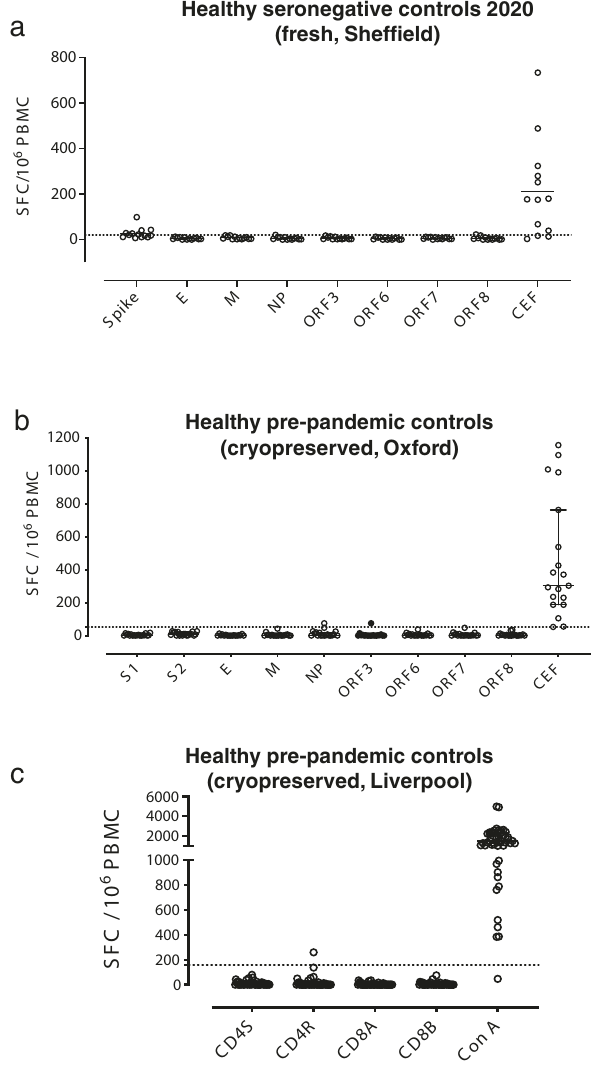
(Supplementary Fig. 5d, P = 0.066 by Wilcoxon ’ s two-tailed test). We again examined cytokine expression in these patients. The low level of responses, as these individuals were not screened using ELISpot, prevented us from effectively examining CD8 + T cell cytokine expression. However, there were suf fi cient indivi- duals with enough responding cells to examine CD4 + T cytokine expression for M ( n = 10), NP ( n = 4), S1 ( n = 6) and S2 ( n = 3). The vast majority of cells expressed 1 – 2 functional markers (with similar patterns), with small populations of cells expressing 3 or 4 (Supplementary Fig. 5). These results were similar to the ELISpot positive individuals mentioned above.